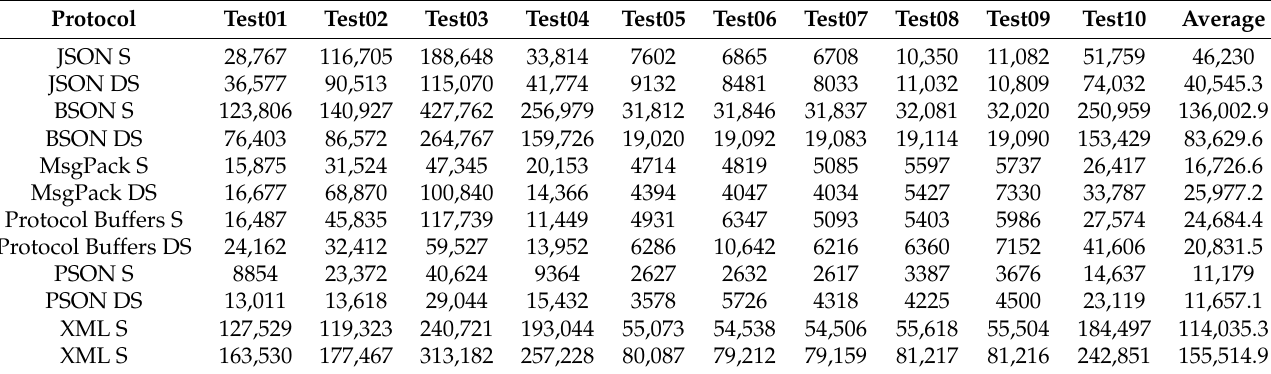
Figure 4. Arduino UNO Serialization (S)/Deserialization (DS) speed. Table 3. ESP32 Serialization (S)/Deserialization (DS) speed.